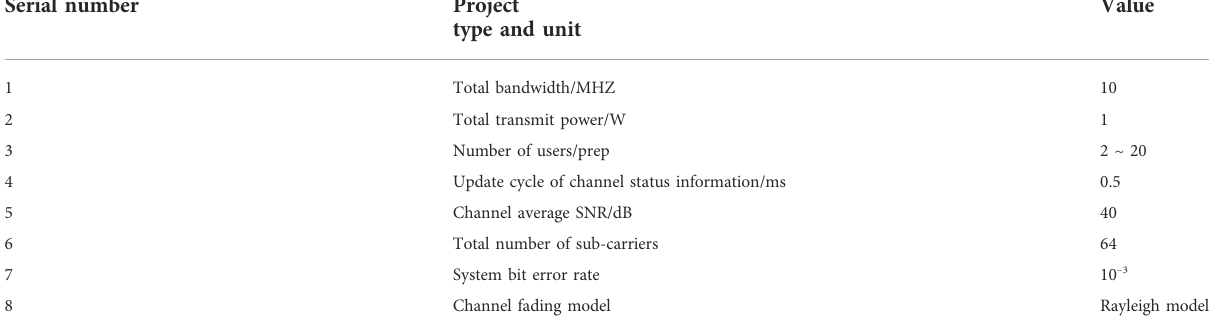
TABLE 1 Test environment parameters of wireless network communication system. Serial